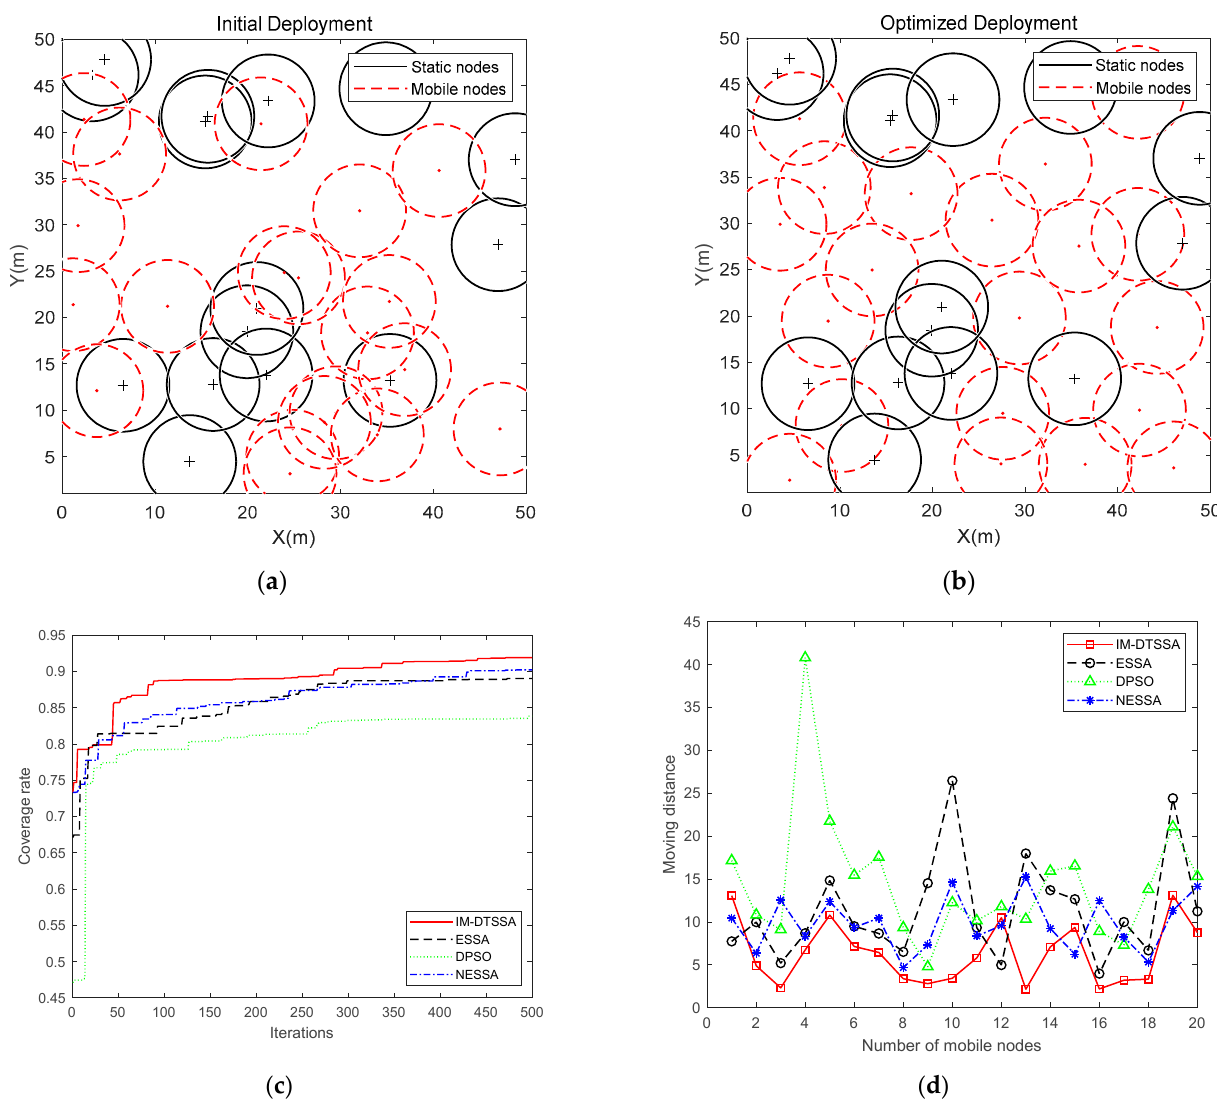
Figure 7. 50 m × 50 m coverage optimization comparison: ( a ) Initial Deployment; ( b ) Optimized Deployment; ( c ) Iteration curves of the four algorithms; ( d )The moving distance of each node. Table 2. Comparison of WSN performance in the area of 50 m × 50 m.